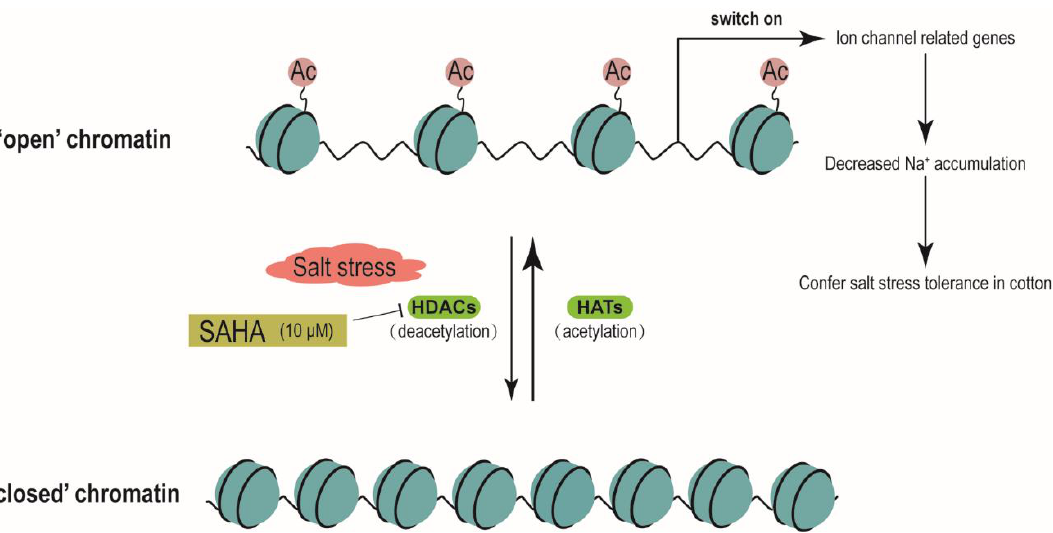
Figure 7. A proposed model for SAHA improvement of salt stress in cotton. Histone acetylation level is balanced by the antagonistic activities of HDACs and HATs. HDACs can remove acetyl groups and lead to a “ closed ” chromatin structure to repress gene expression. The expression of ion homeostasis-related genes could be turned off due to removal of acetyl groups by recruitment of HDACs to gene promoters. Pretreatment of exogenous SAHA could efficiently inhibit the activity of some HDACs and may lead to global hyperacetylation, which results in an “ open ” chromatin to activate the expression of ion homeostasis-related genes. Under salt stress, induced expression of ion homeostasis-related genes could enhance the ability to maintain Na + /K + homeostasis and alleviate the ion toxicity in cotton.